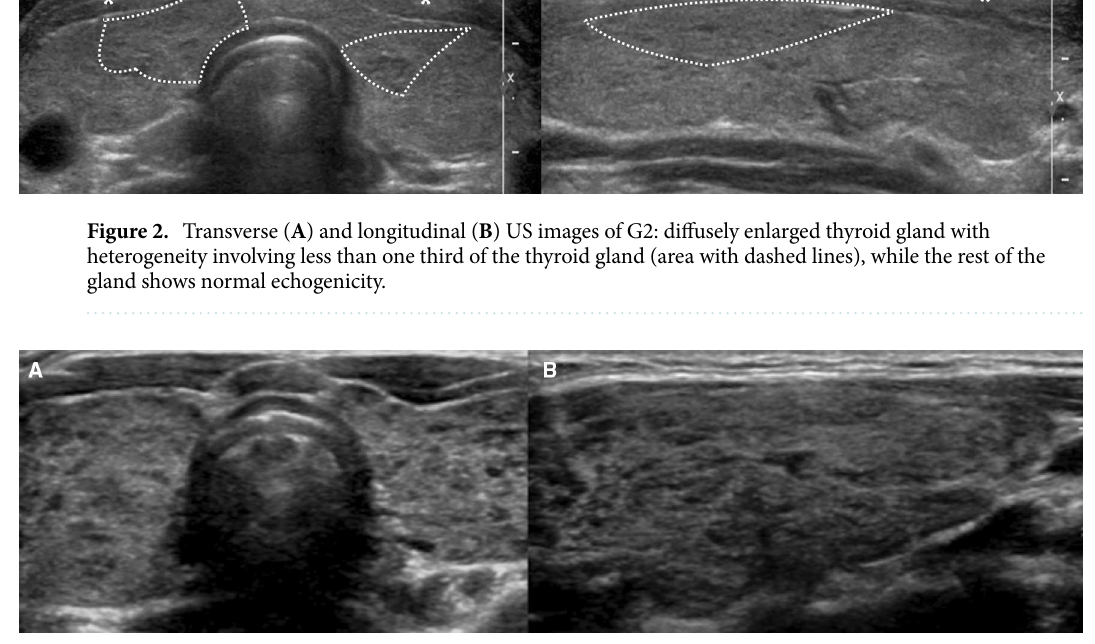
Figure 3. Transverse ( A ) and longitudinal ( B ) US images of G3: diffusely enlarged thyroid gland with heterogeneity involving more than one third of the gland while the rest of the gland shows isoechogenecity compared with the anterior strap muscle.